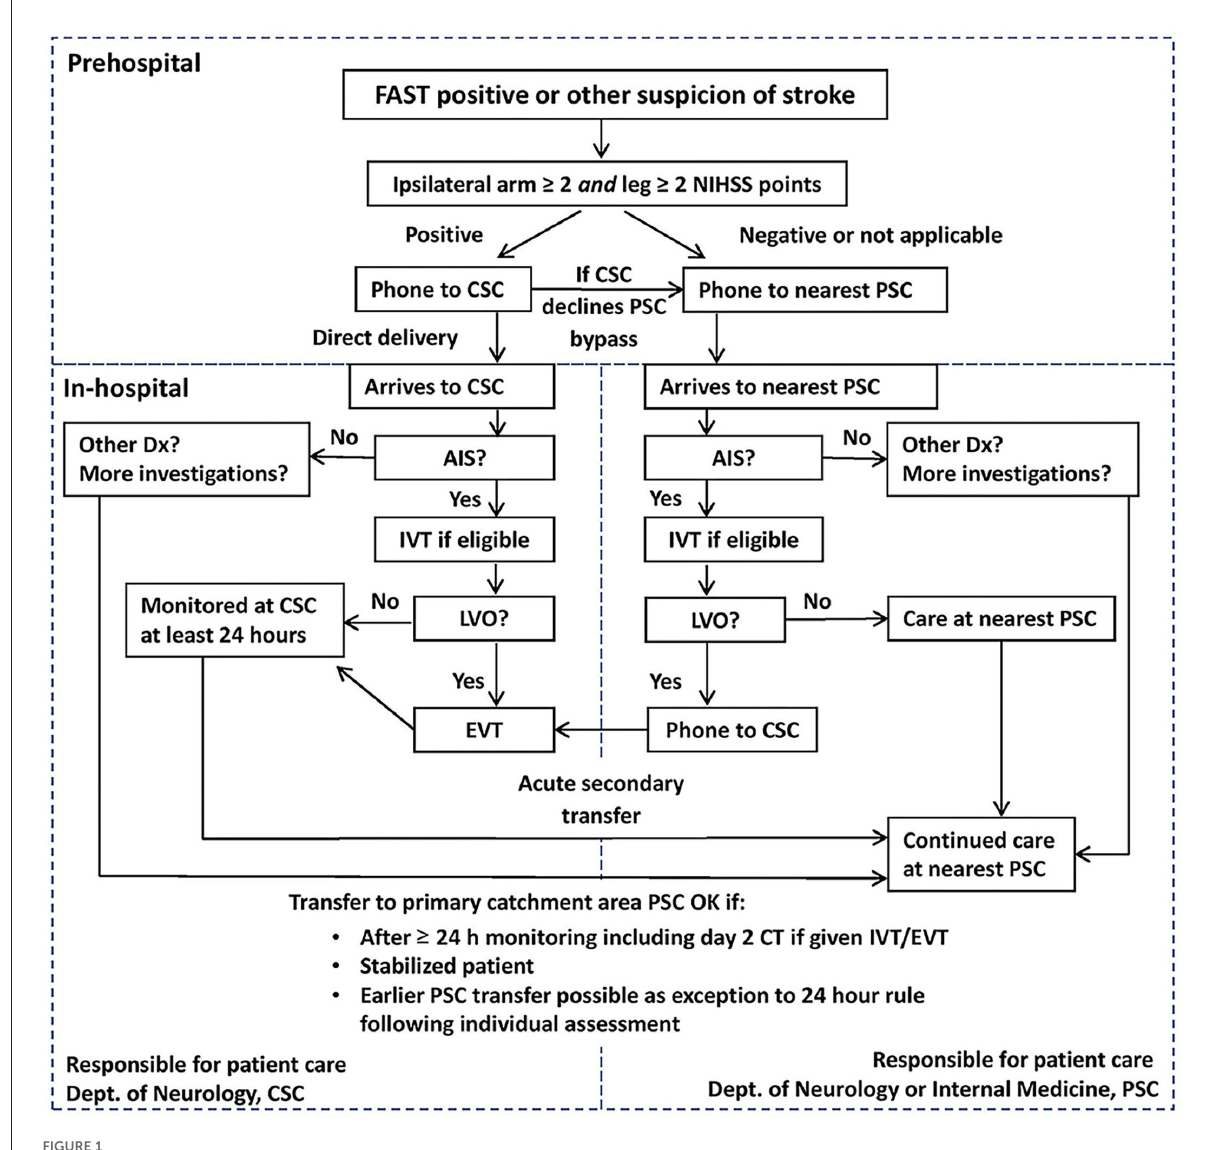
FIGURE1 Flowchart of the Stockholm Stroke Triage